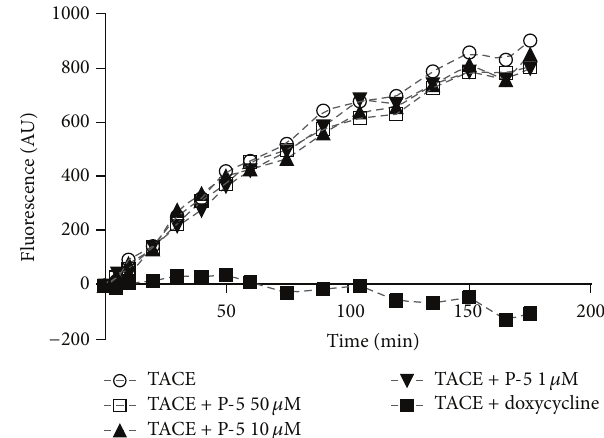
Figure 3: Cleavage of the fluorescent peptide substrate Mca-P-L-A- Q-A-V-Dpa-R-S-S-S-R-NH 2 by purified human recombinant TACE in the presence of elevated concentrations of P-5 or doxycycline.